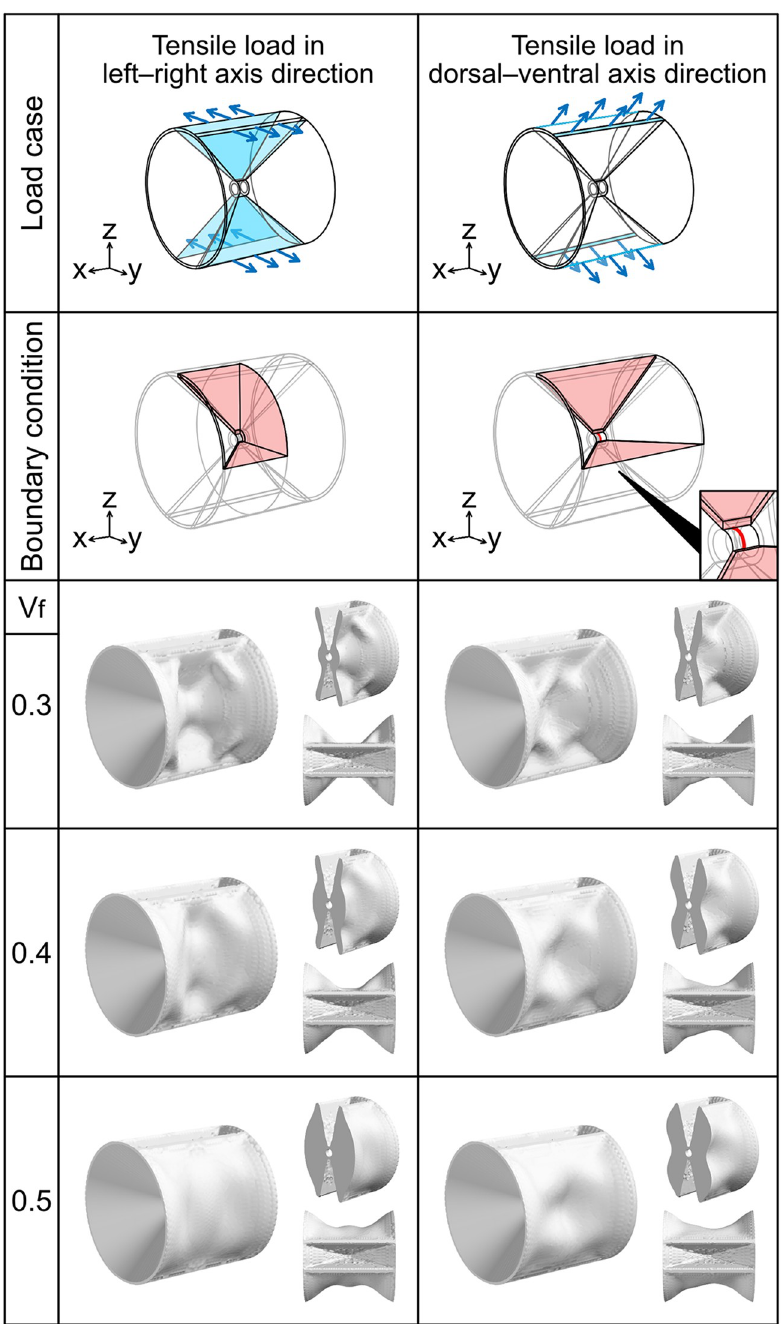
Fig 6. Optimization for tensile loads to vertebral arches. The arrangement and color scheme of the images are the same as those described in Fig 3. For the tensile load in left–right axis direction, we imposed the symmetric boundary condition u � n = 0 to the pink-colored areas on the xy, yz, and zx planes and used an eighth model. For the tensile load in dorsal–ventral axis direction, we imposed the symmetric boundary condition to the pink-colored areas on the xy and zx planes and used a quarter model. We also imposed the displacement constraint u x = 0 to the edge y 2 + z 2 = C R2 ( y � 0 and z � 0, the red line). The bottom right of the second row shows the magnified image of the center of the analysis